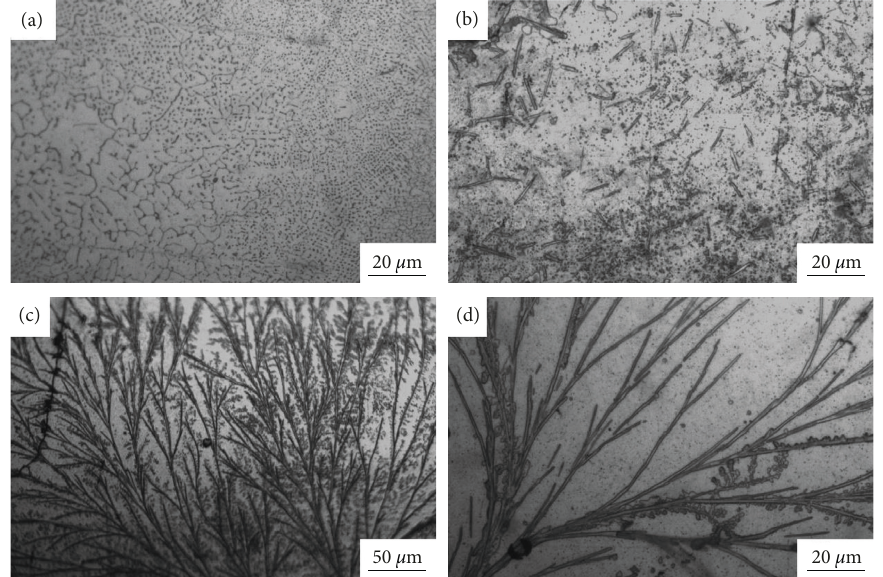
Figure 8: Metallographic structure of different compositions after heat treatment. (a) Mo-4.5Si-2B, (b) Mo-4.5Si-3.5B, (c, d):